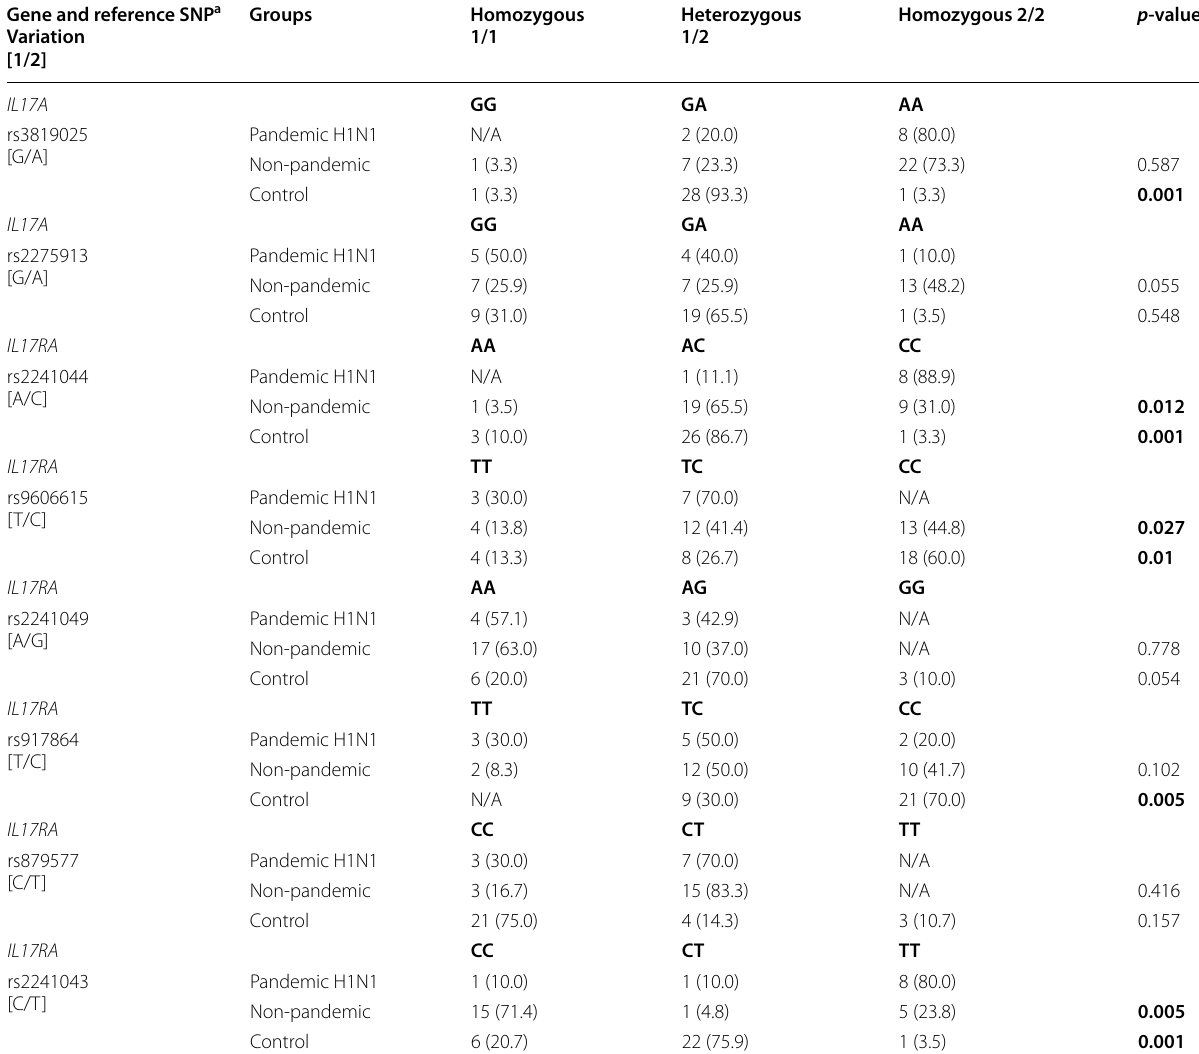
Table 2 Genotypic analysis of the tag SNPs in the IL17A and IL17RA gene in the addictive